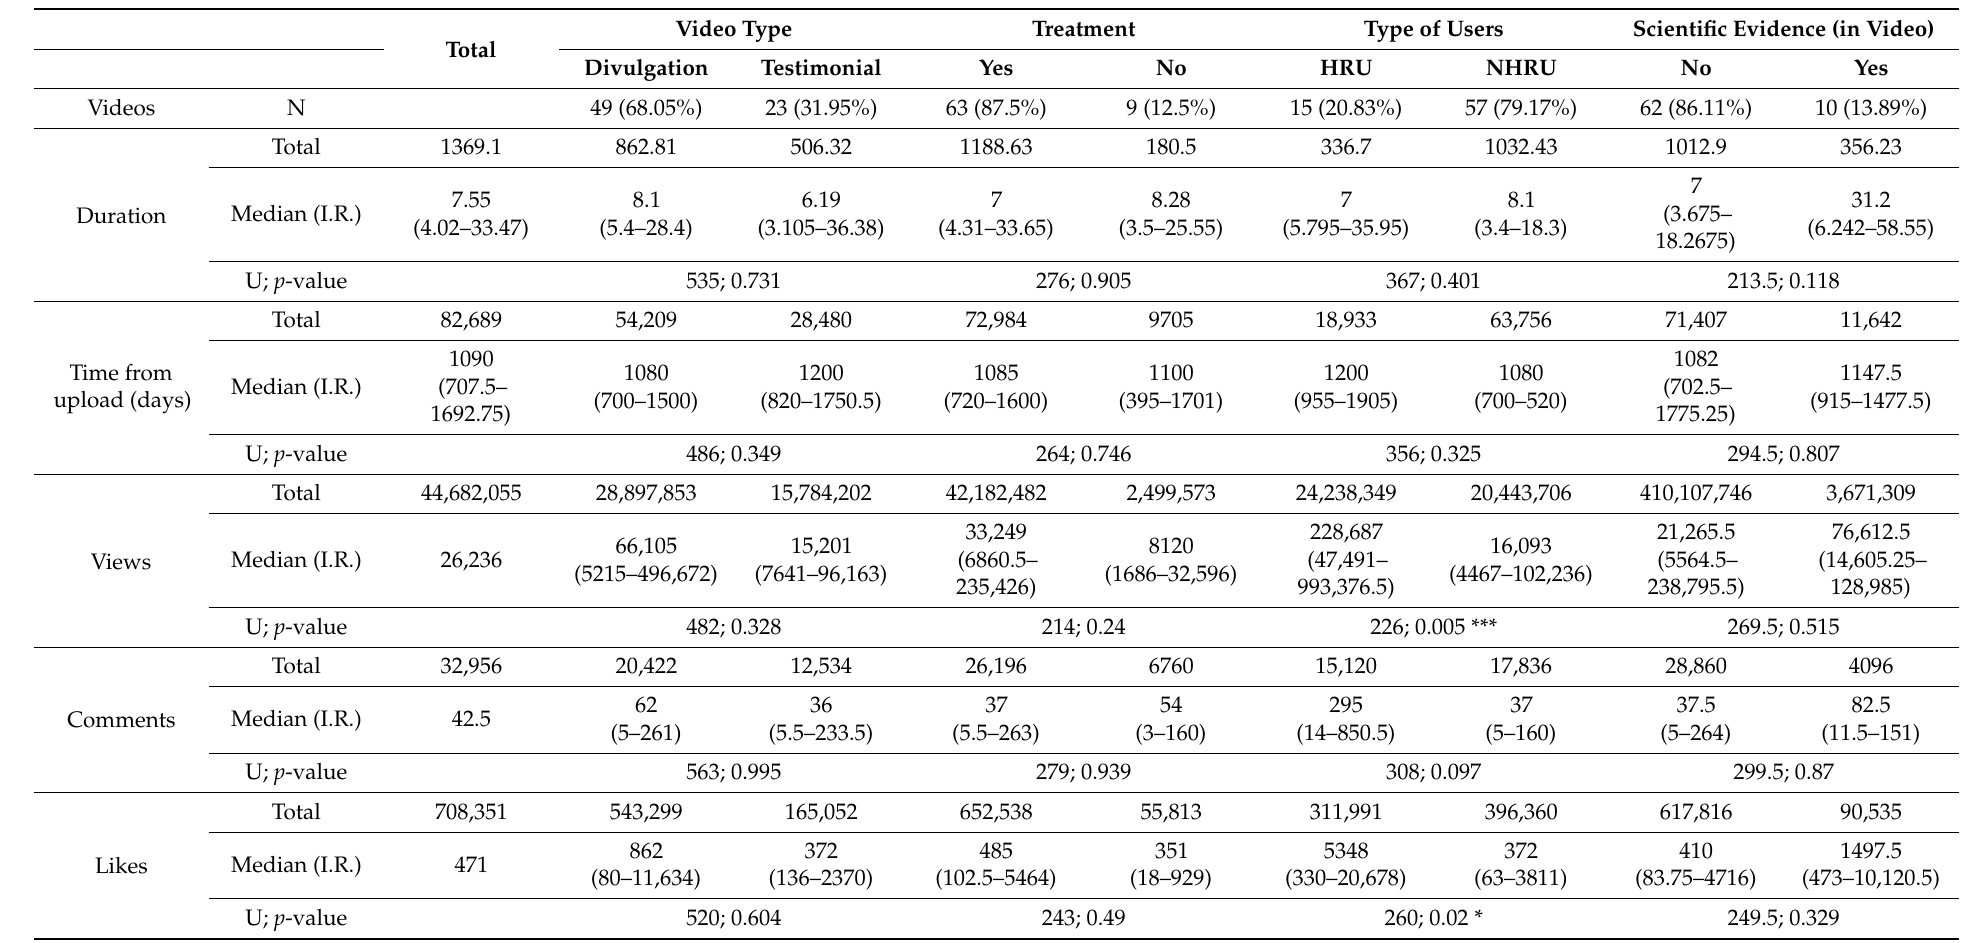
Table 3. Description of video features by